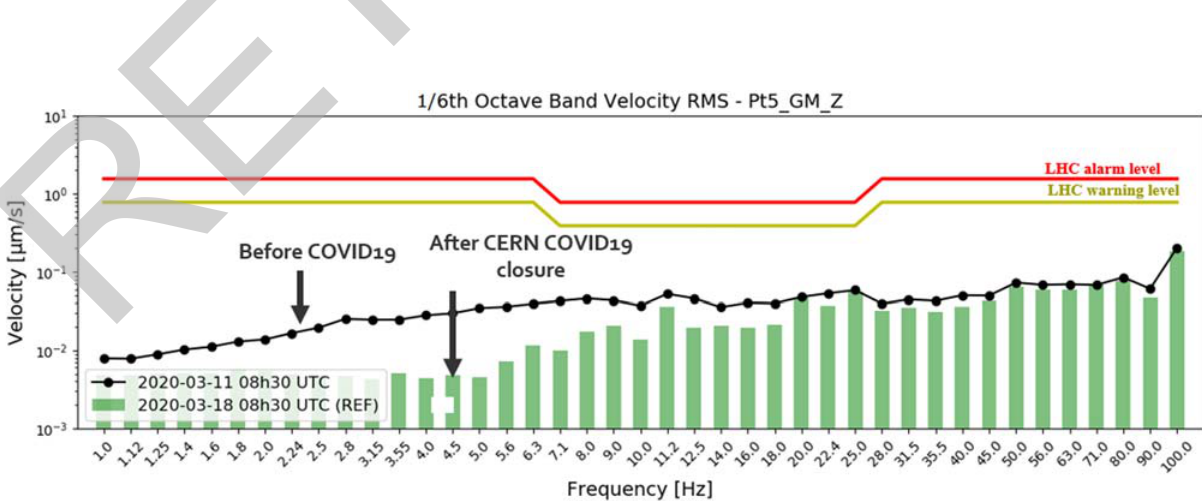
Figure 7: The 1/6th Octave Band Velocity RMS for 20 - min data block, comparison of data before and after the lockdown at CERN point 5 ( CMS ) seismic